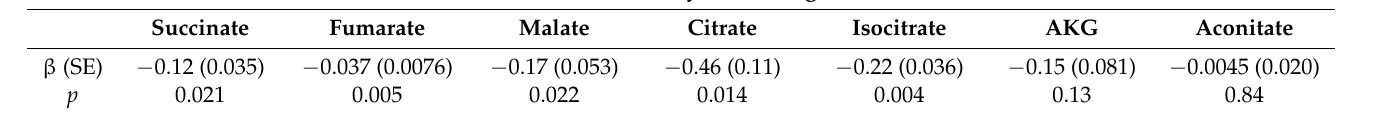
Prediction of CAC Marker by PCr-R: Regression with Robust SE